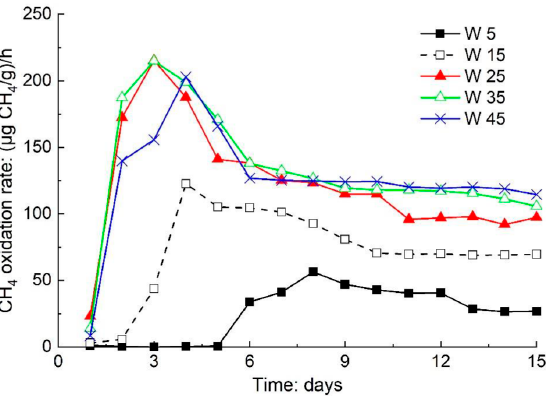
Figure 4. Methane oxidation rate of cover soil with different water contents versus time.